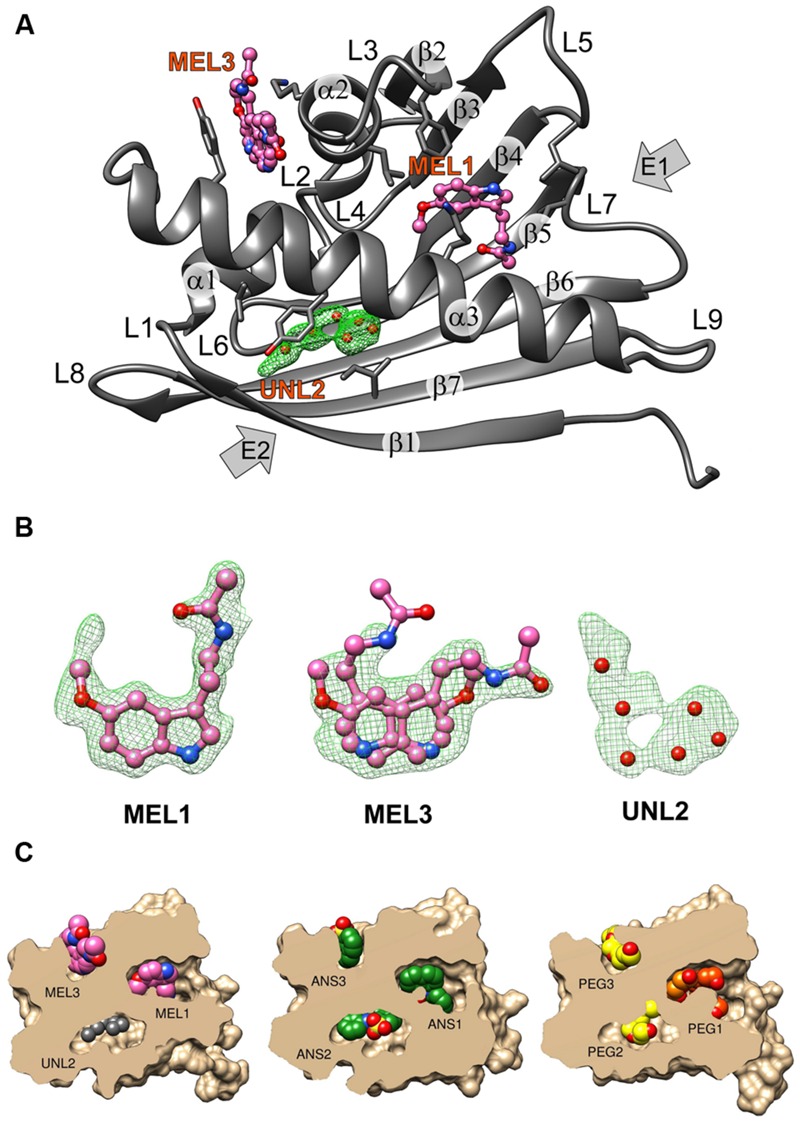
(A) The crystal structure of the Hyp-1/MEL complex with annotation of the canonical structural elements of the PR-10-fold. Residues that are in contact with the ligand molecules at <3.8 Å are shown as sticks. MEL molecules 1 and 3 are shown in ball-and-stick representation whereas the unknown ligand at site 2 is represented by its OMIT Fo–Fc electron density contoured at 2.5σ and marked with six dummy water molecules (red spheres). (B)
Fo–Fc OMIT maps contoured at 2.5σ corresponding to MEL1 at site 1, MEL3 at site 3 and UNL at site 2. (C) Structures of the Hyp-1 complexes with MEL (this work), ANS (4N3E, chain K), and PEG (3IE5, chain B) shown in cutaway surface representation. The ligand molecules are shown as van der Waals models. “PEG” denotes various fragments (oligomers) of polyethylene glycol, a buffer component that was serendipitously bound by the Hyp-1 protein in the experiments conducted by Michalska et al. (2010).